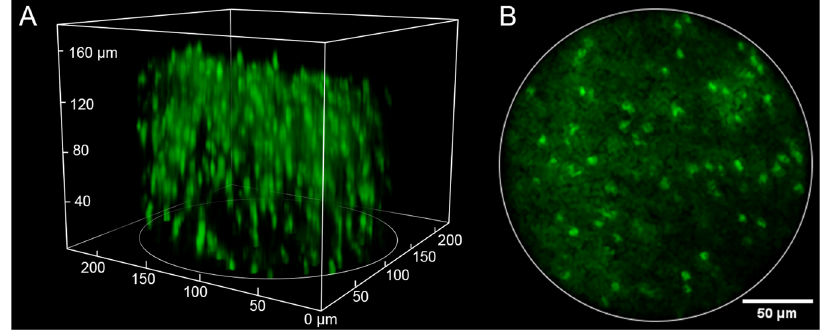
Figure 3. ( A ) Two photon image showing a 3D volume acquired by the 2P-FCM (220 × 220 μ m lateral × 180 μ m axial) with over 200 cells in the image. The sample is fixed mouse cortical tissue (4% paraformaldehyde) expressing green fluorescent protein (GFP) driven by proteolipid protein promoter. The GFP labels oligodendrocyte cell bodies in the cortex. ( B ) Processed image of a single slice in the stack after filtering to remove pixelation